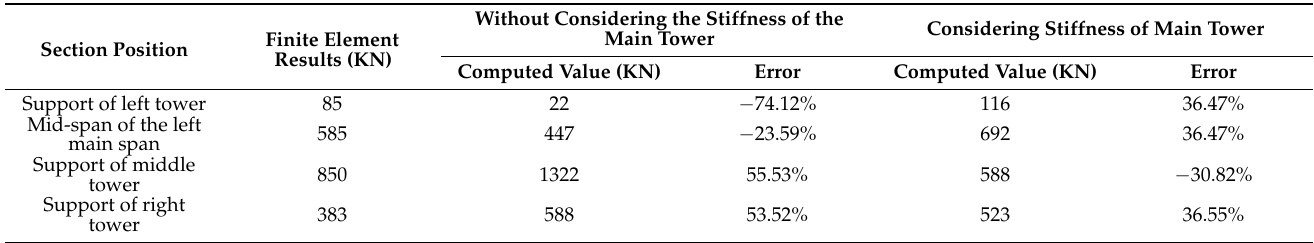
Table 3. The shearing force of control section of stiffening beam under live load in the middle section of left main